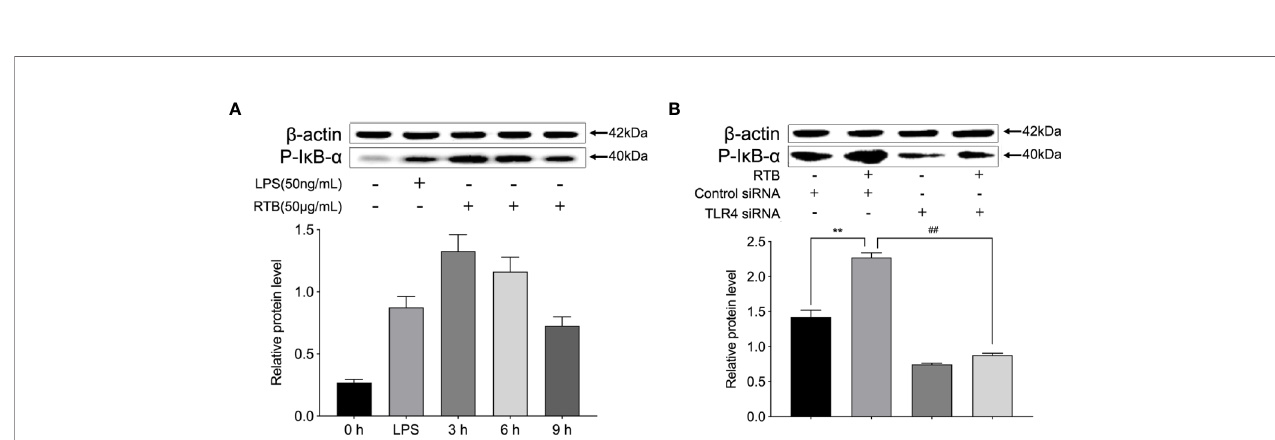
FIGURE 5 | pI k B expression in Raw264.7 cells treated with RTB. (A) Raw264.7 cells were treated with RTB (50 m g/mL) for 3, 6, or 9 h or LPS (50 ng/mL) for 6 h. Levels of pI k B were determined by western blotting. The relative protein levels are expressed as the relative ratios versus actin. Representative results from one of three experiments with similar results are shown. Values are the mean ± SD of three replicates. (B) TLR4 stably transfected RAW264.7 cells were stimulated with RTB (50 m g/mL), and pI k B levels were determined by western blotting. Representative results from one of three experiments with similar results are shown. Values are the mean ± SD of three replicates. **p < 0.01 compared to control siRNA group. ## p < 0.01 compared to control siRNA treated with